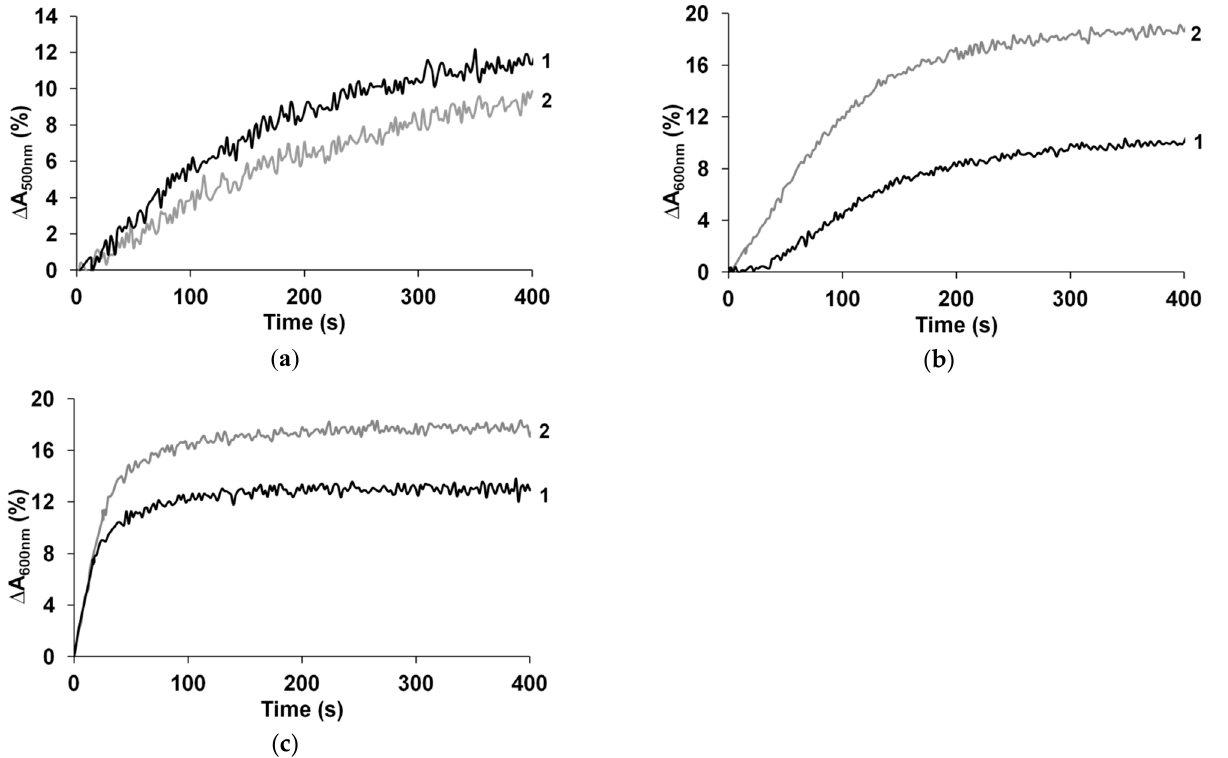
Figure 7. Influence of excessive proton replacement on the sensing properties of PEDOT-t-PASA ( a ), PANI-t-PASA ( b ) and PANI-PAMPSA ( c ) 1—as prepared, 2—treated in 10% CaCl 2 , exposed to 52 ppm NH 3 .